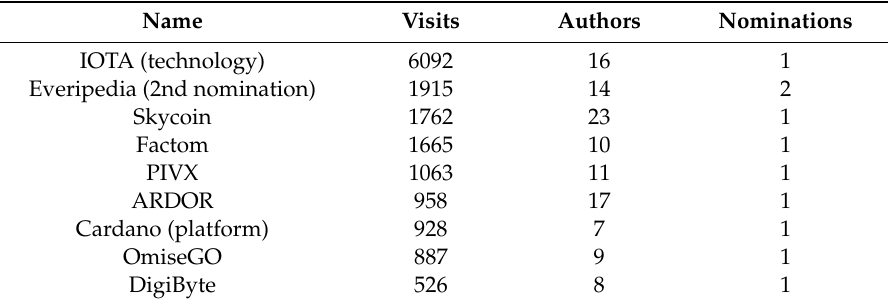
Table 4. Number of authors and deletion nominations for particular